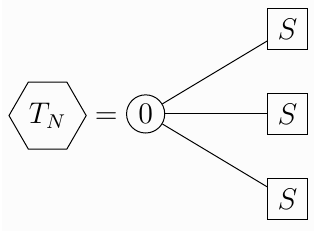
Figure 7 . The 3d mirror of the T N theory is obtained by taking three copies of T (SU( N )) theory and gauge its diagonal SU( N ) symmetry. The circle with zero in it symbolizes the gauging with zero Chern-Simons level, i.e. the N = 4